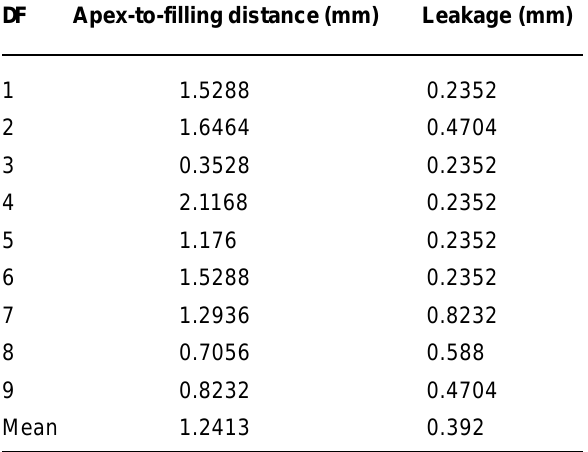
TABLE 3- Apex-to-filling distance (mm) and leakage extent (mm) in the disrupted-filled (DF) group